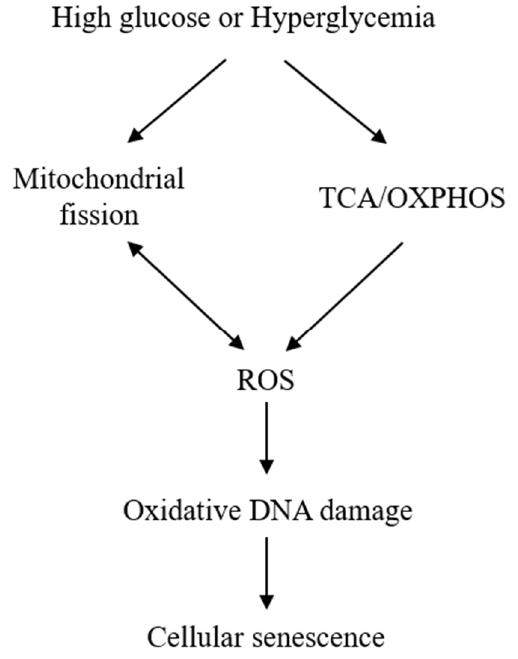
Figure 1. Simplified scheme illustrating the mechanism by which high glucose (HG) induces cellular senescence . HG enhances tricarboxylic acid (TCA) cycle and oxidative phosphorylation (OXPHOS), which results in reactive oxygen species (ROS) generation. HG induces mitochondrial fission, which is accompanied by ROS accumulation. ROS, in turn, induces mitochondrial fission as indicated by a two-head arrow. Sublethal ROS (H2O2) induces oxidative DNA damage and senescent phenotypic changes.